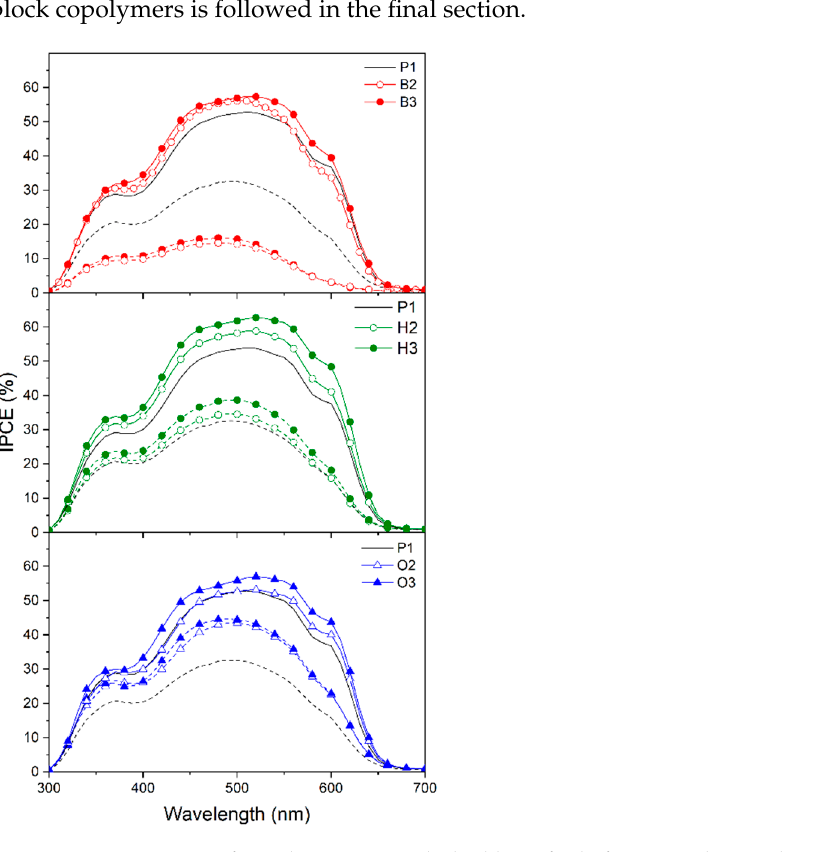
Figure 9. IPCE spectra of copolymer series: dashed lines for before annealing and solid lines for after annealing.